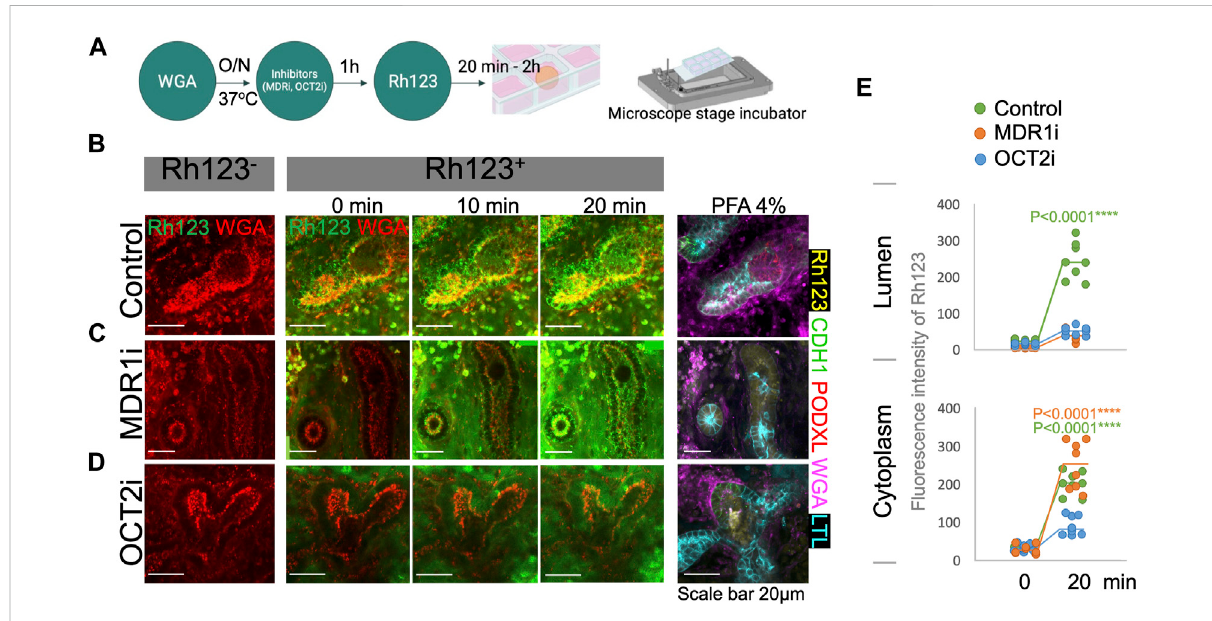
FIGURE 4 Rh123 transport is mediated by MDR1 and OCT2 in kidney organoids. (A) Protocol for Rh123 assay using transporter inhibitors. (B) Rh123 transport into the lumen of proximal tubules in the control samples. (C) MDR1i blocks luminal secretion of Rh123, resulting in fl uorescence accumulation in the apical cytoplasmic region. (D) OCT2i decreases the Rh123 luminal secretion and cellular uptake. (E) Quanti fi cation of the Rh123 intensity in the tubular lumens and cytoplasm n = 6. ****: p <